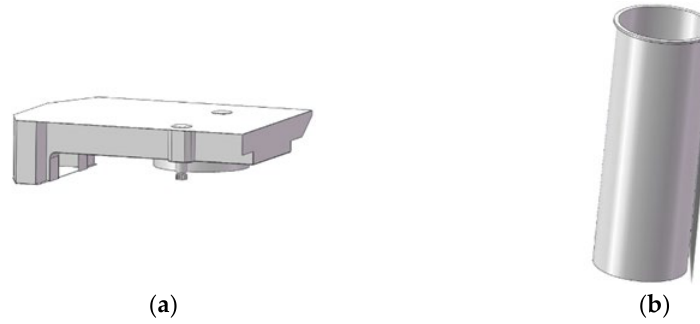
Figure 2. ( a ) Turntable structure model; ( b ) cylinder structure model.